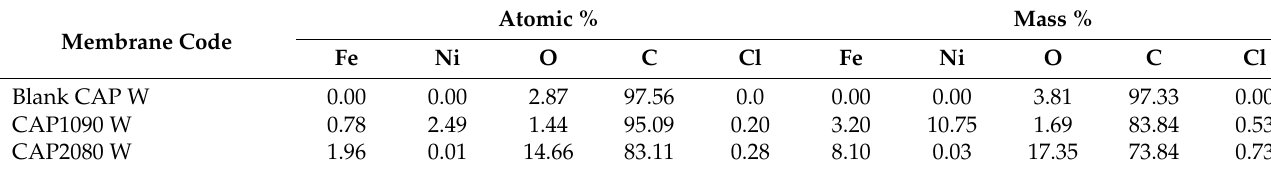
Table 4. EDX analysis of the fabricated blank CA and magnetic mixed CA matrix membranes using TEM